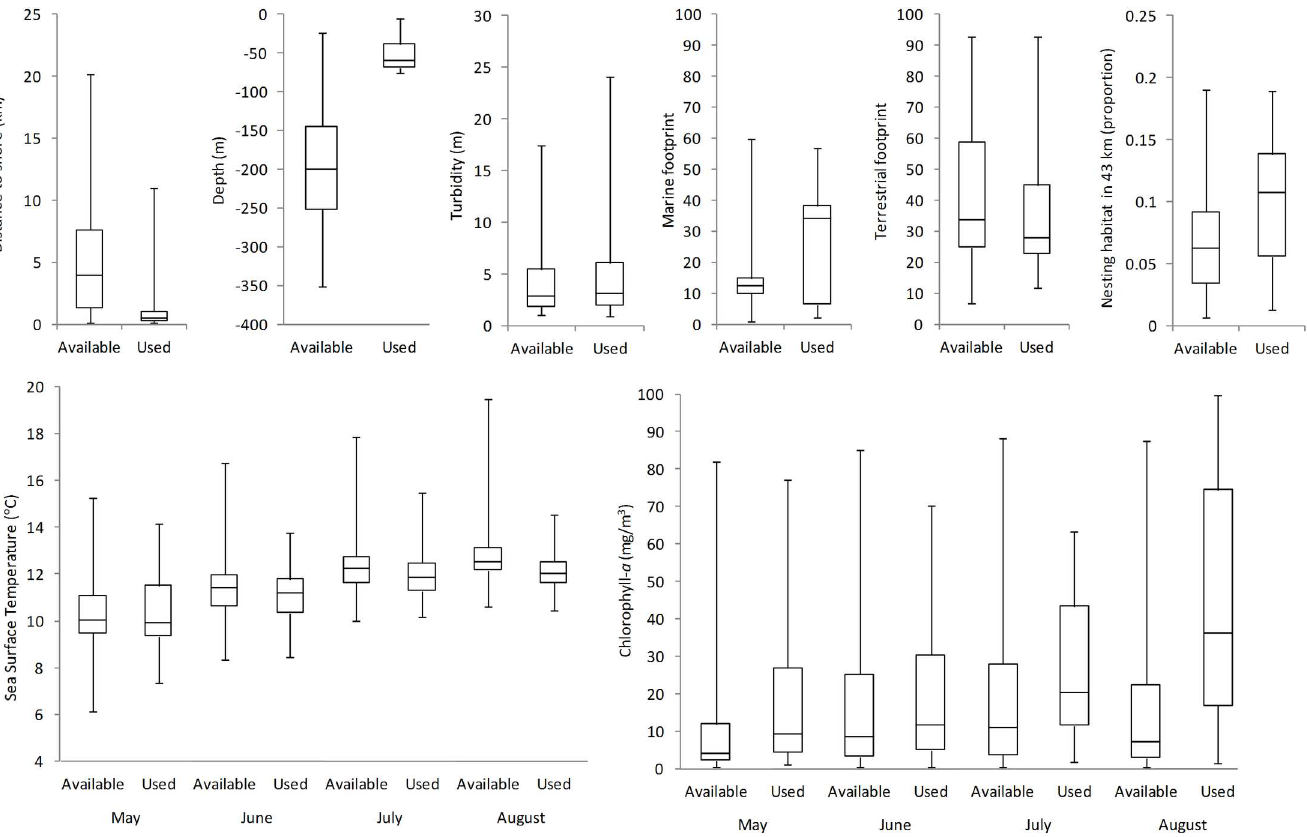
Fig 2. Comparison of habitatfeaturesat locationsavailable versus used by marbledmurreletsin northwestern Washington,U.S.A., and southwestern BritishColumbia,Canada,2004–2008. Box plots show maximum(top whisker), minimum(bottomwhisker),first and thirdquartiles(IQR; top and bottomline of box), and median(centerline of